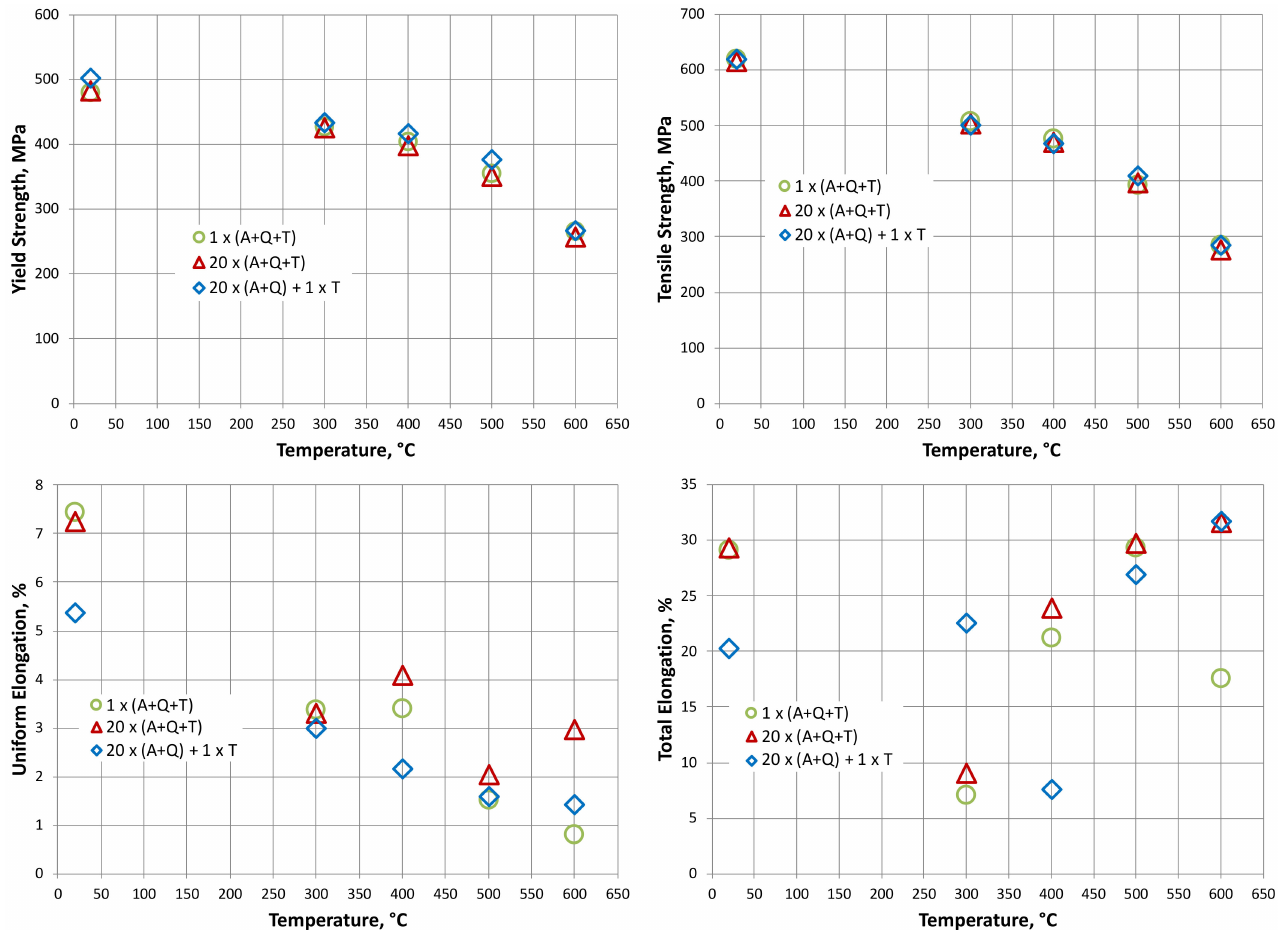
Figure 6. The effect of multiple heat treatments on the tensile properties of EUROFER97/2 (25 mm plate, heat 993402). The reference samples (circles) were austenitized at 980 ◦ C for 30 min (A), air quenched (Q), tempered at 750 ◦ C for 2 h (T), and finally air cooled. For comparison, another set of samples was 20 times heat treated the same way, i.e., 20 × (A + Q + T). Finally, another set was prepared by 20 times repeating only austenitization and quenching, i.e., 20 × (A + Q), which was then followed by one tempering treatment (1 × T). The tensile tests were performed according to DIN EN ISO 6892-1 using cylindrical specimens (gauge: diameter 3 mm, length 18 mm). The tensile axis was always oriented parallel to the rolling